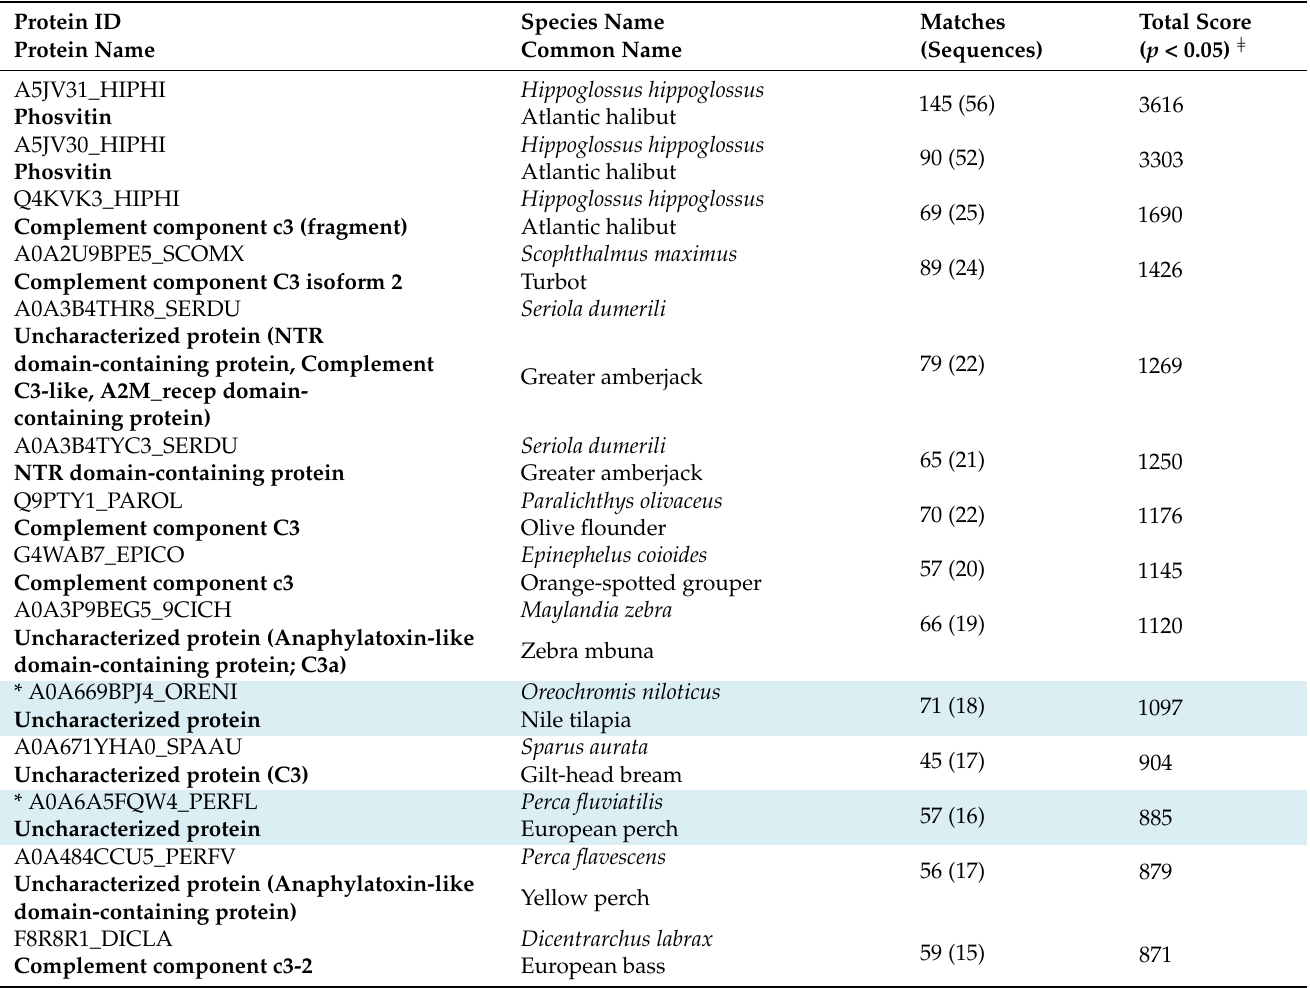
Table 2. Total protein cargo in serum-EVs of halibut ( Hippoglossus hippoglossus L), as identified by LC-MS/MS analysis from serum-EVs isolated from a pool of sera from n = 4 fish. Peak list files were submitted to Mascot, using the Teleost UniProt database. Peptide sequence hits are listed, showing the number of sequences for protein hits and total score. Species hit names are indicated. In the case of uncharacterised protein ID, proteins matching the same set of peptides are indicated in brackets. Protein hits highlighted in blue (*) were not identified in the F95 enriched fraction. Protein names are written in bold. A full list of protein sequence hits and peptides is further provided in Supplementary Table